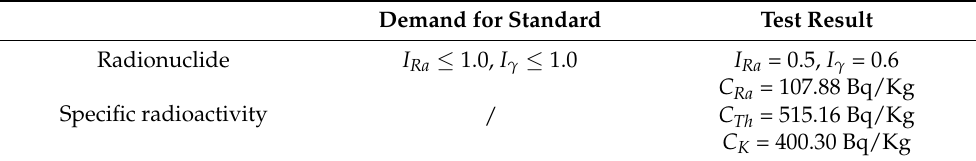
Table 7. The content of radionuclide and specific radioactivity for the HPG-E composites.